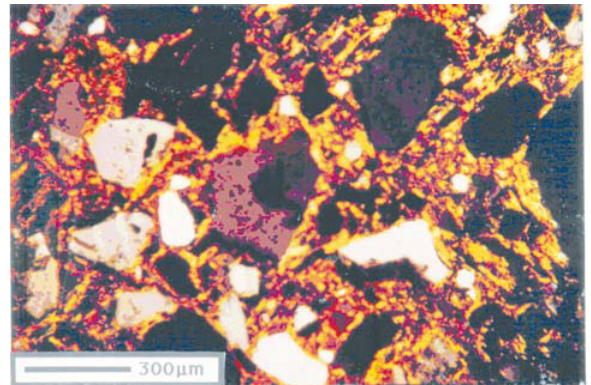
Figura 6. Mesma micrografia da figura 5, tirada com nicóis cruzados.Verifica-se a separação do plasma em volta de grão e poro e na matriz do solo.